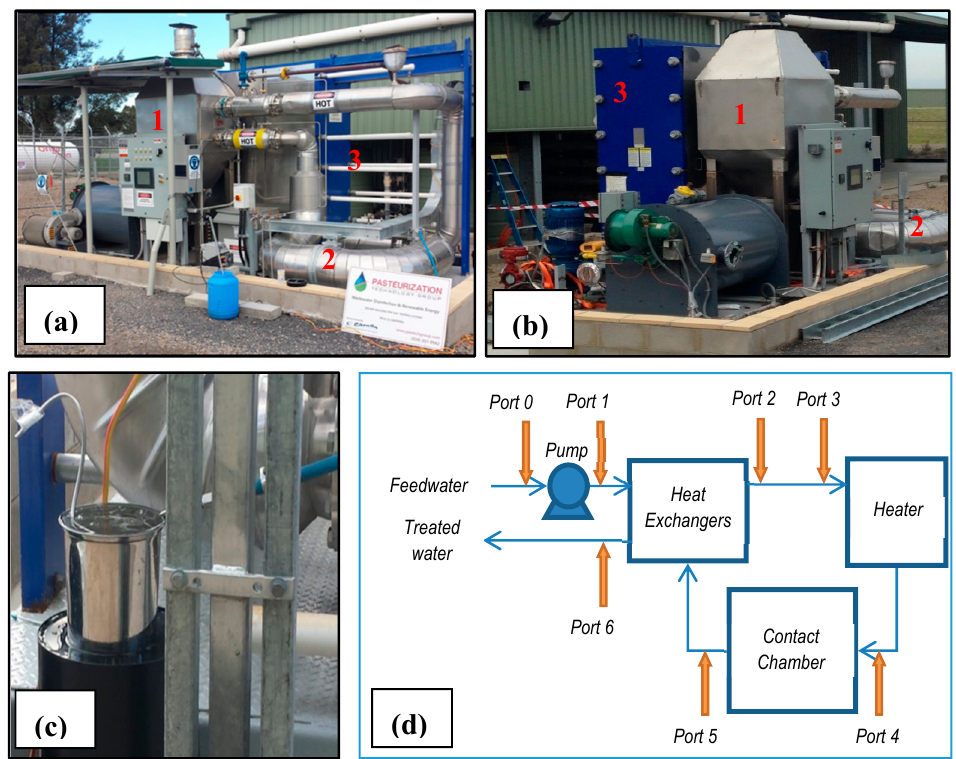
Figure 1. Pasteurisation pilot plant. ( a and b ): frontal view and side view showing key pilot plant components: heater (1), contact chamber (2) and heat exchangers (3); ( c ): ice bath sample chilling device used for Port 5 samples; and ( d ): process schematic showing location of sample ports and key pilot plant components.